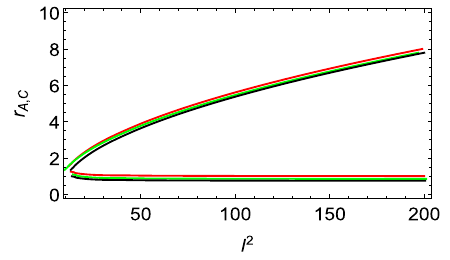
for given other min